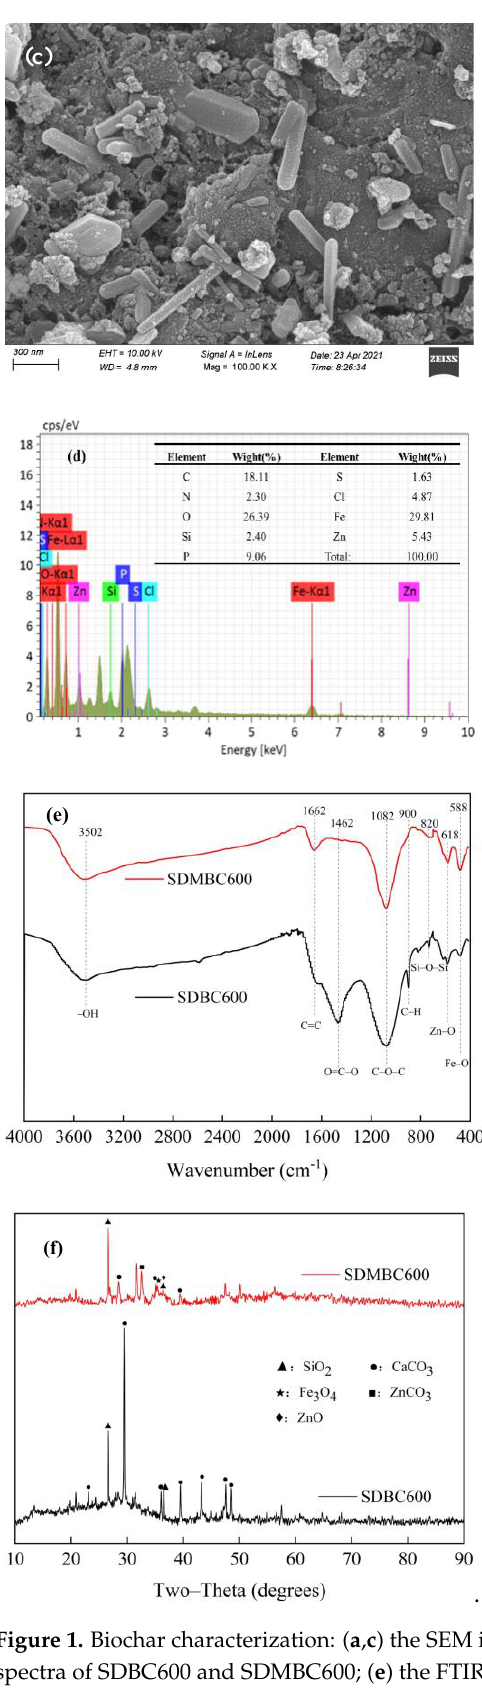
Figure 1. Biochar characterization: ( a , c ) the SEM images of SDBC600 and SDMBC600; ( b , d ) the EDS spectra of SDBC600 and SDMBC600; ( e ) the FTIR spectra of SDBC600 and SDMBC600; ( f ) the XRD diffraction pattern of SDBC600 and SDMBC600. BET was used to determine the N 2 adsorption- desorption curves of SDMBC600 (see Table S1 and Figure S1). The N 2 adsorptions-